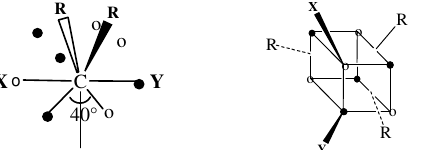
Figure 9. LDQ presentation of transition state for inversion (left) and retention of configuration (right).